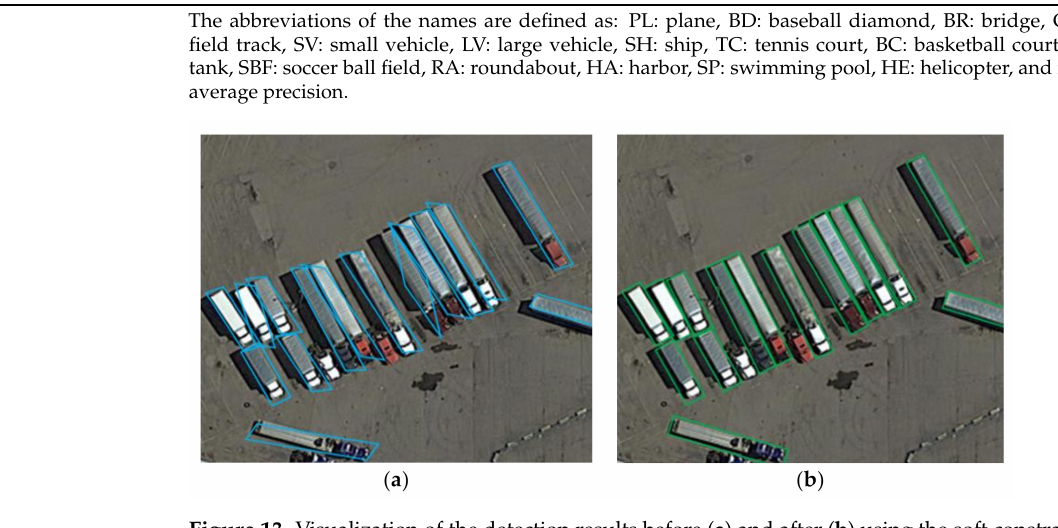
Figure 13. Visualization of the detection results before ( a ) and after ( b ) using the soft constraint method.